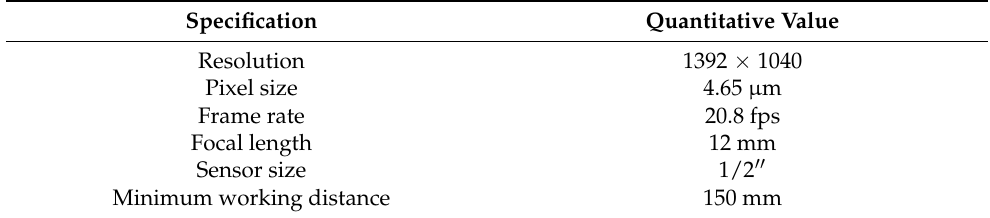
Table 1. Specifications of 3CCD Jai